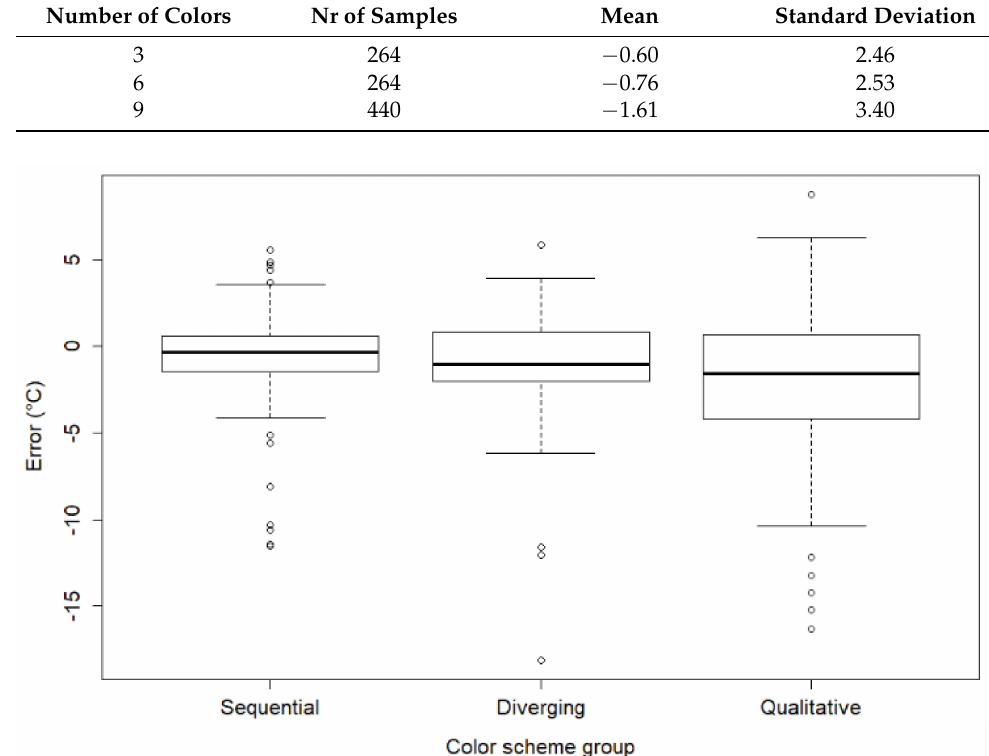
Figure 9. Spread of error according to the color scheme group.